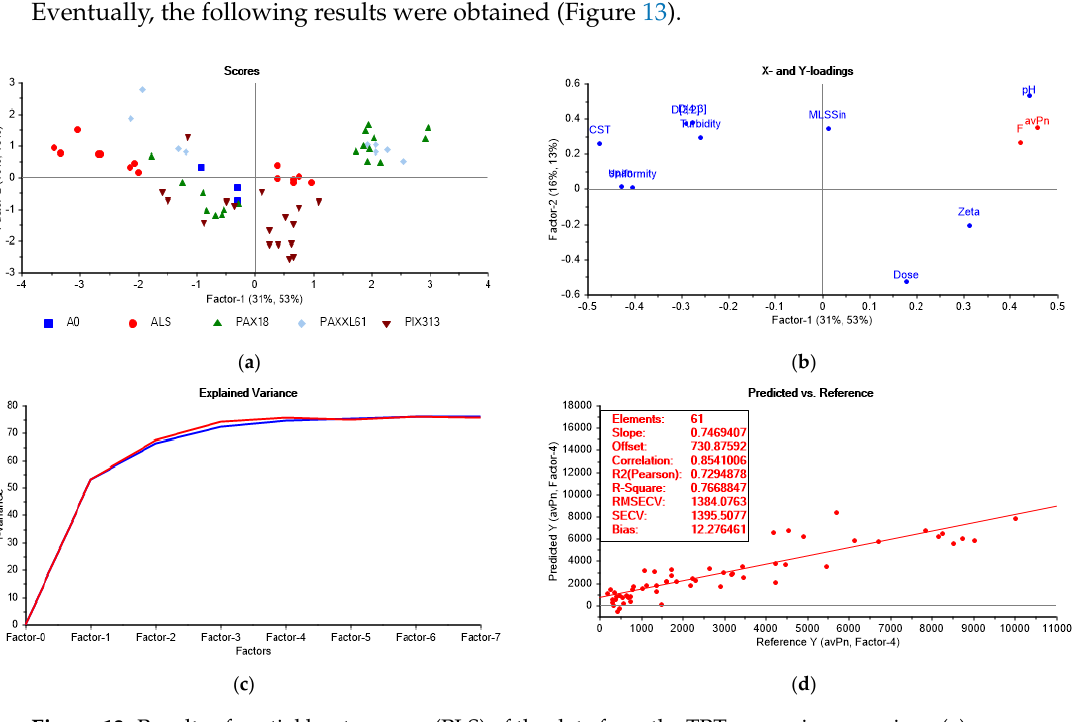
Figure 13. Results of partial least squares (PLS) of the data from the TRT-regression overview: ( a ) scores plot; ( b ) loadings plot; ( c ) total residual variance plot; ( d ) fouling intensity prediction model.